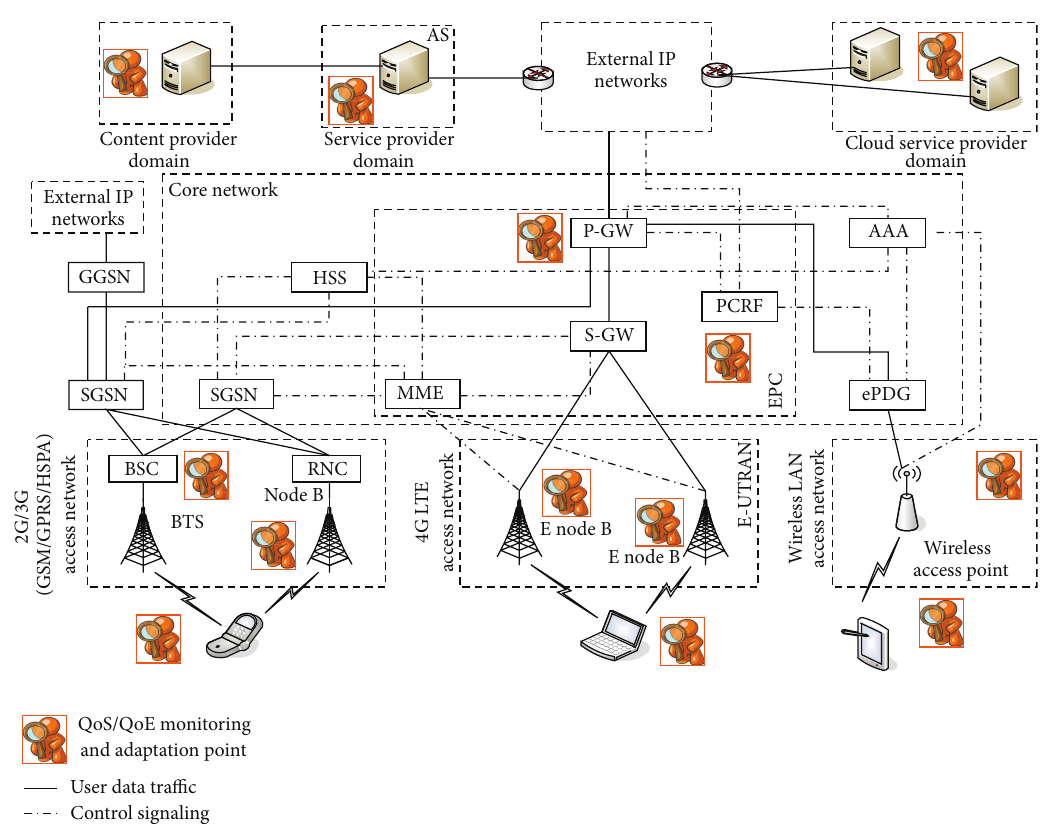
Figure 2: QoE/QoS monitoring and adaptation points in a wireless network environment (see